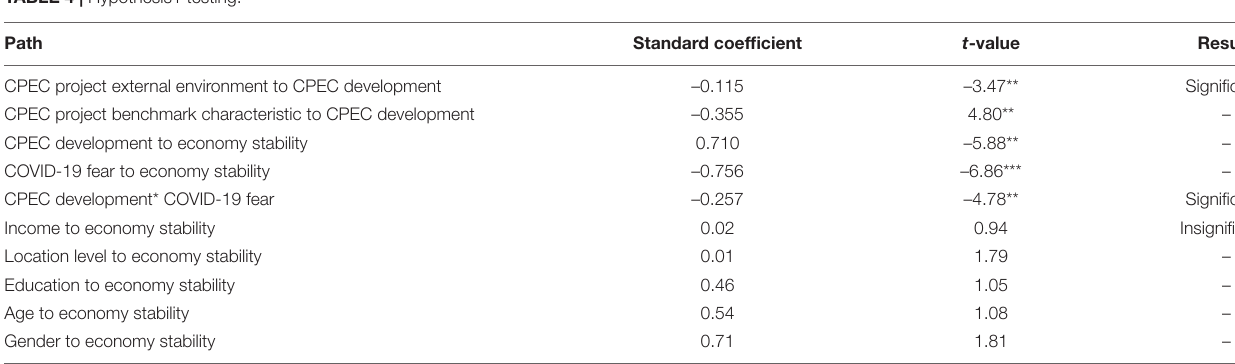
TABLE 4 | Hypothesis1